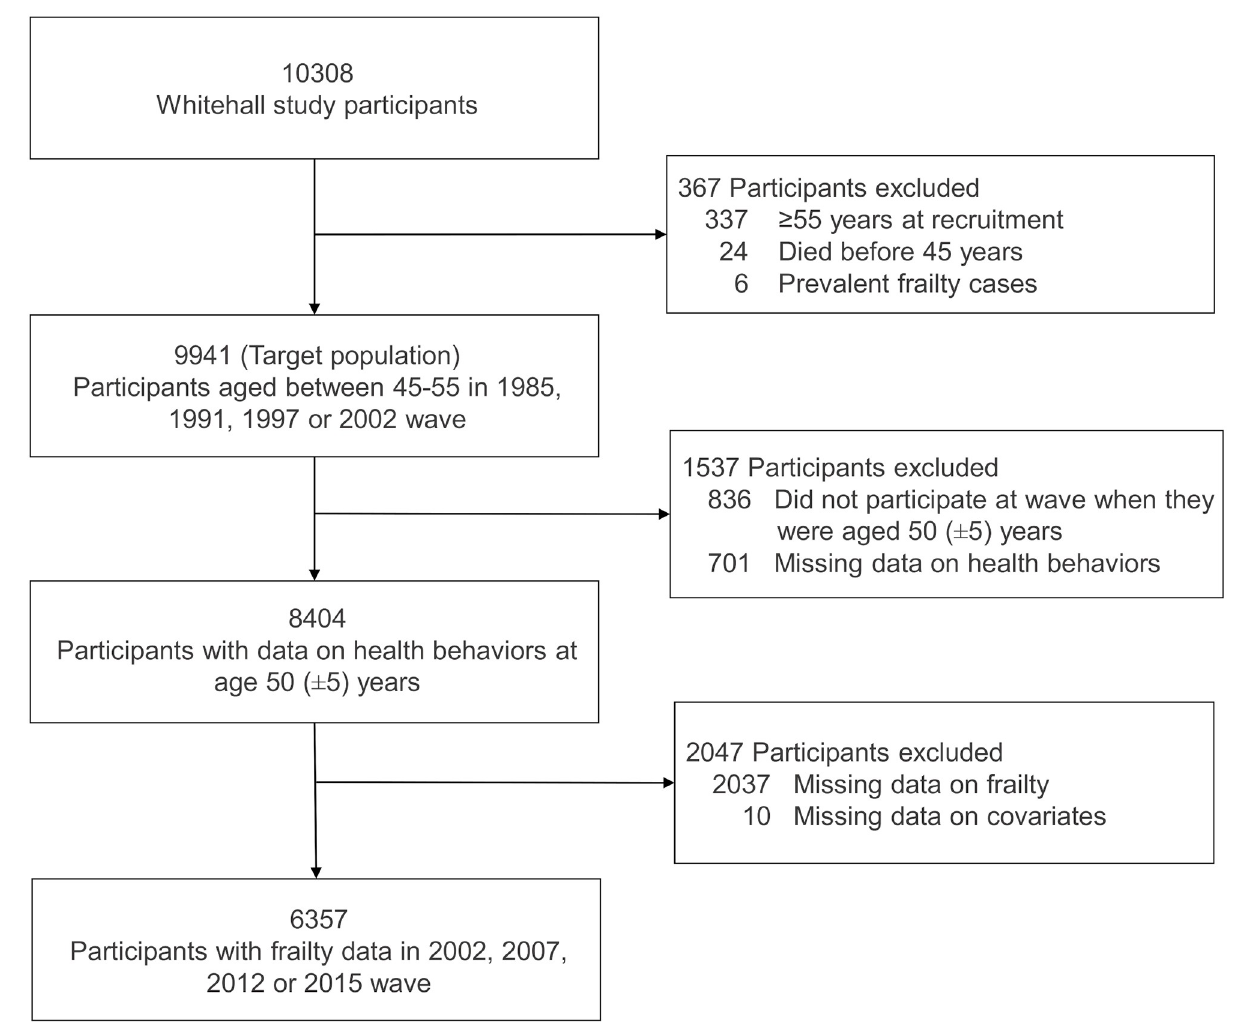
Fig 1. Flowchart of sample